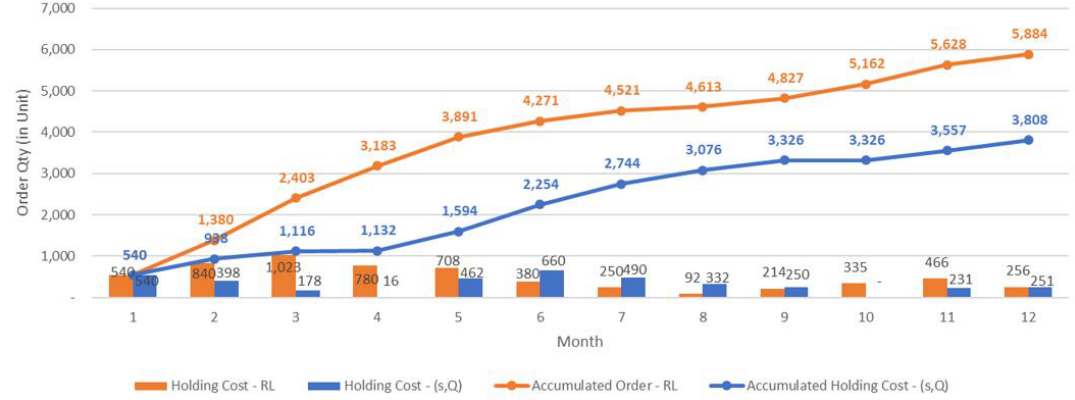
Fig. 4 Holding Cost Agent 1B - Scenario 2